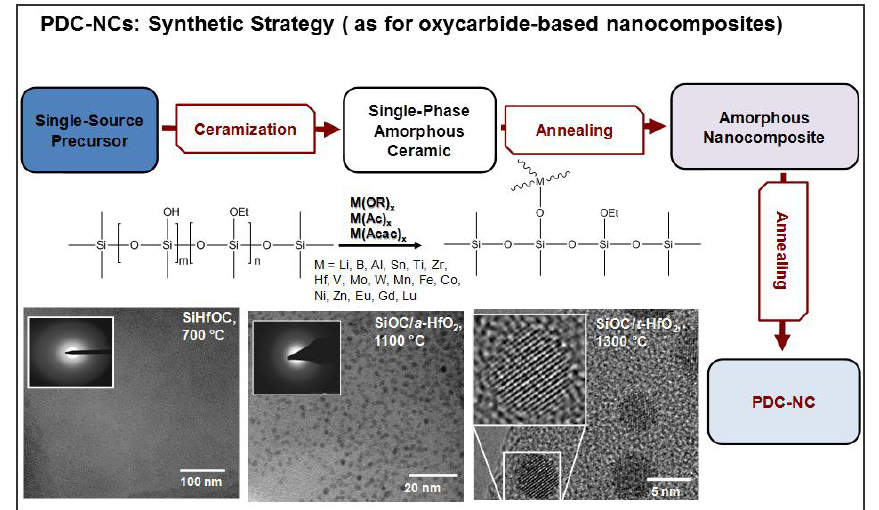
Figure 1. Preparative strategy for polymer-derived ceramic nanocomposites (PDC-NCs) from suitable single-source precursors (as for oxycarbide-based PDC-NCs): the TEM micrographs depict the evolution of the phase composition in the case of a SiHfOC-based material